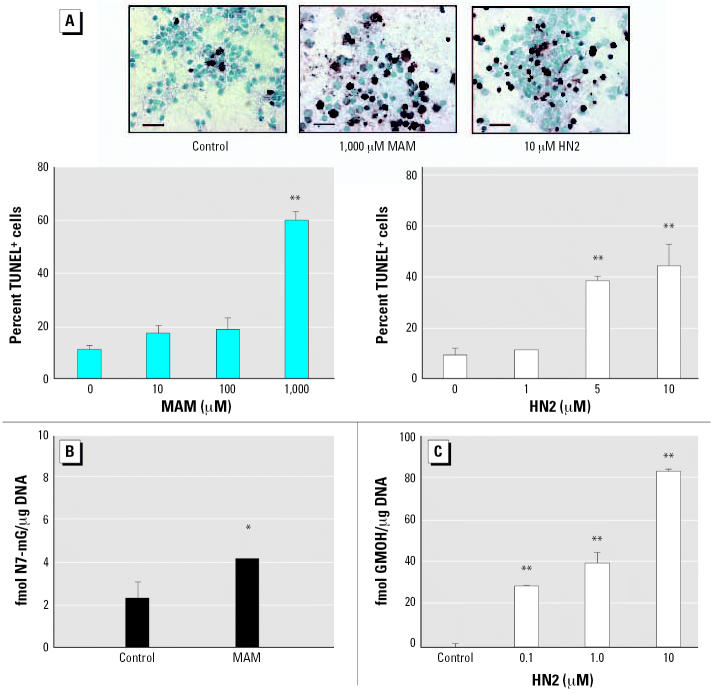
In situ DNA damage of cerebellar neurons treated with MAM or HN2. (A–C) Representative light micrographs of cerebellar neurons treated for 24 hr with various concentrations of MAM or HN2 and examined for the extent of DNA fragmentation by TUNEL labeling (A) or N7-alkylguanine DNA lesions induced by 100 μM MAM (B) or 0.1–10 μM HN2 (C). Note the extensive labeling of neurons treated with 10μM HN2 or 1,000 μM MAM. Bar = 50 μm.Significantly different from control-treated neurons (*p < 0.05 or **p < 0.01 by ANOVA).